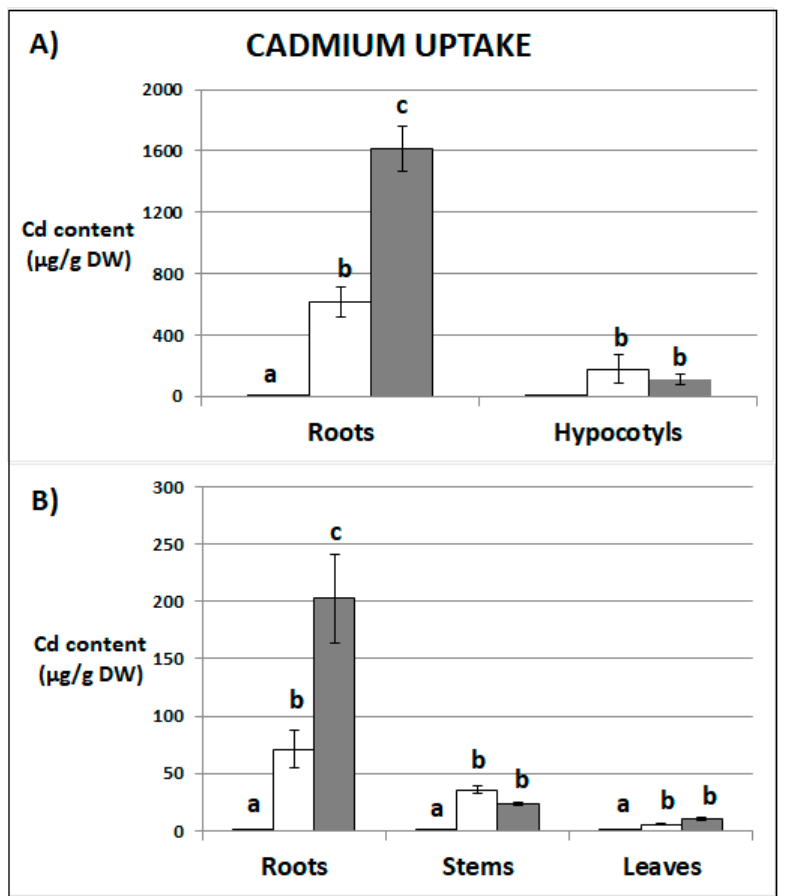
Figure 1. Cadmium content in roots and hypocotyls of soybean seedlings ( A ) and roots, stems, and first leaves of recovered plants ( B ). Black bars—control plants, white bars—plants stressed previously with Cd at the concentration 10 mg/L, dark grey bars—plants stressed previously with Cd at the concentration 25 mg/L. Results are the means of three independent experiments ± SE . Results showing no statistically significant differences in relation to control by p = 0.05 are marked with same letter.